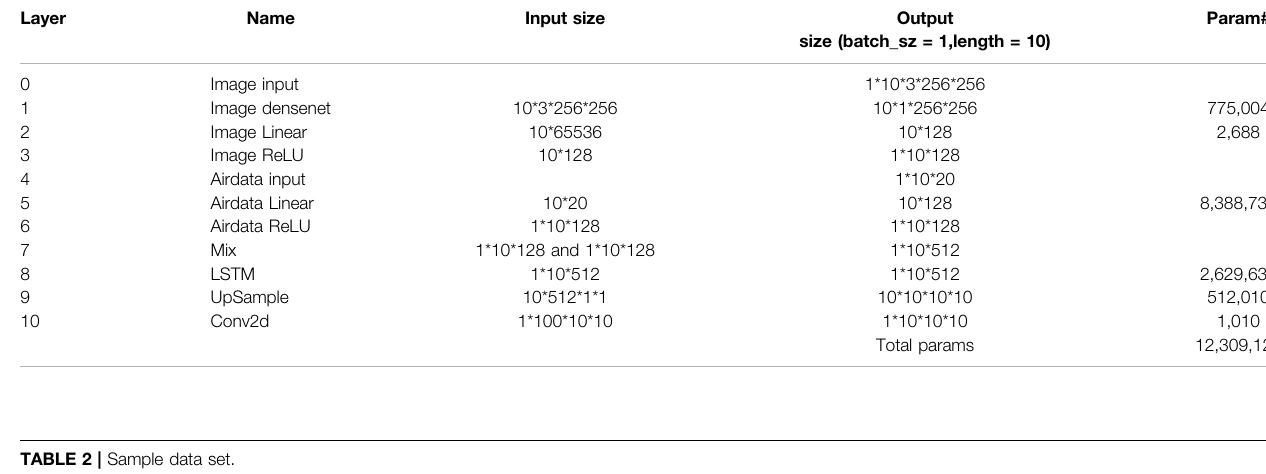
TABLE 1 | Parameters of the model.